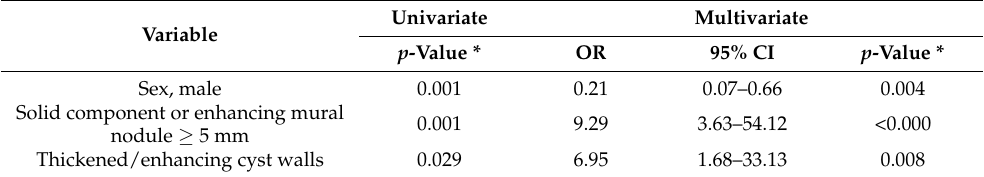
Table 2. Factors associated with HGD in patients with LGD/HGD.